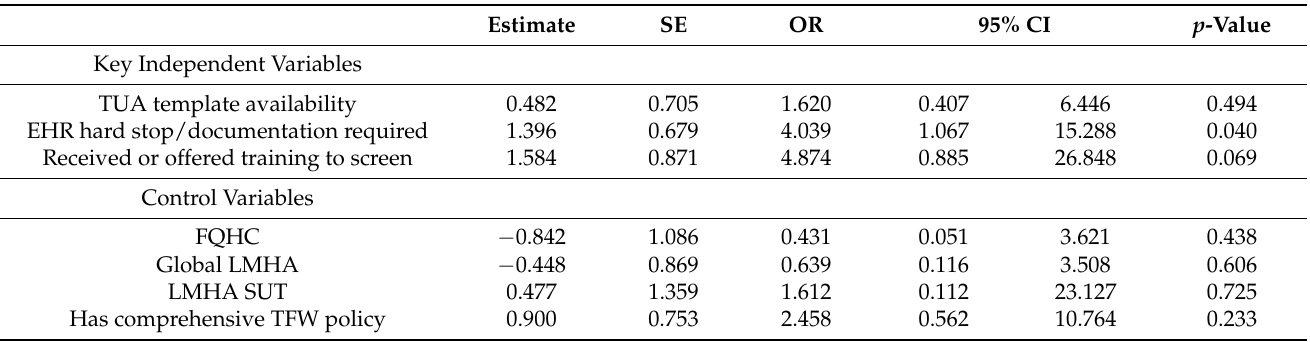
Table 2. The Association of Health Care Center Tobacco Use Screening Mandates in Relation to Health Care Center Practices/Resources, Controlling for Health Care Center Type and Comprehensive Tobacco-Free Workplace Policy Presence ( n = 80). Estimate SE OR 95%